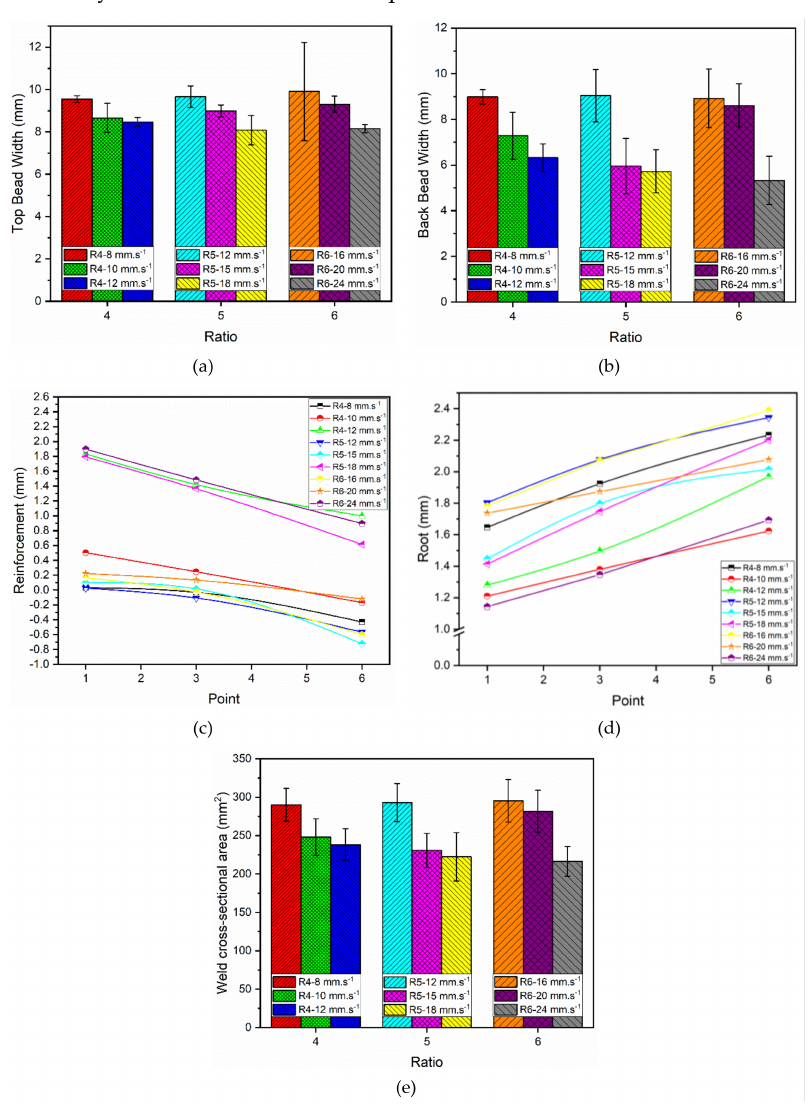
Figure 5. Weld geometry on a various ratio of wire feeder and wire feeder speed: ( a ) top bead width, ( b ) back bead width, ( c ) reinforcement depth, ( d ) root depth and ( e ) weld cross-sectional